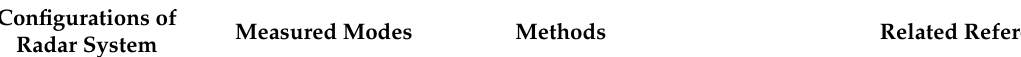
Table 1. Classification of techniques and corresponding